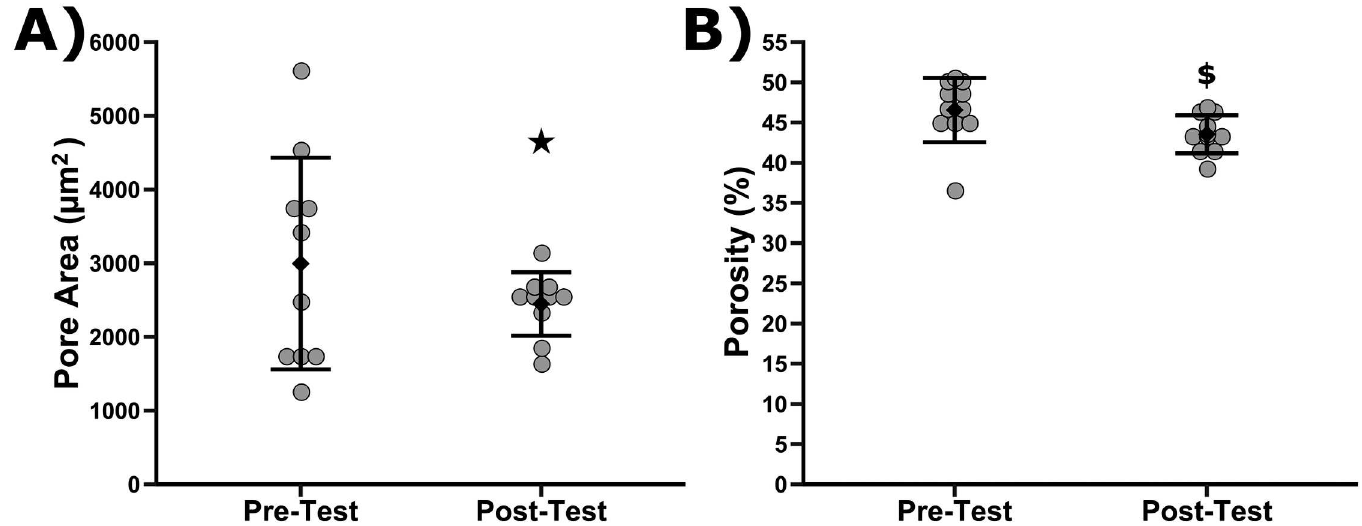
Fig 4. Plot of participant reported pore areas(A) and reported porosity (B) before and after training. Grey symbols are the individualresponses while diamonds are mean with standarddeviation(10 (cid:20) n (cid:20) 11). The star indicatesthat variancein pore area responses for the Pre-Test vs. Post-Test was statistically different (Levene’sTest, P < 0.05). Dollarsign indicatesmeans were statistically different betweenthe Pre-Test and Post-Test (WilcoxonSigned Rank Test, P < 0.05).